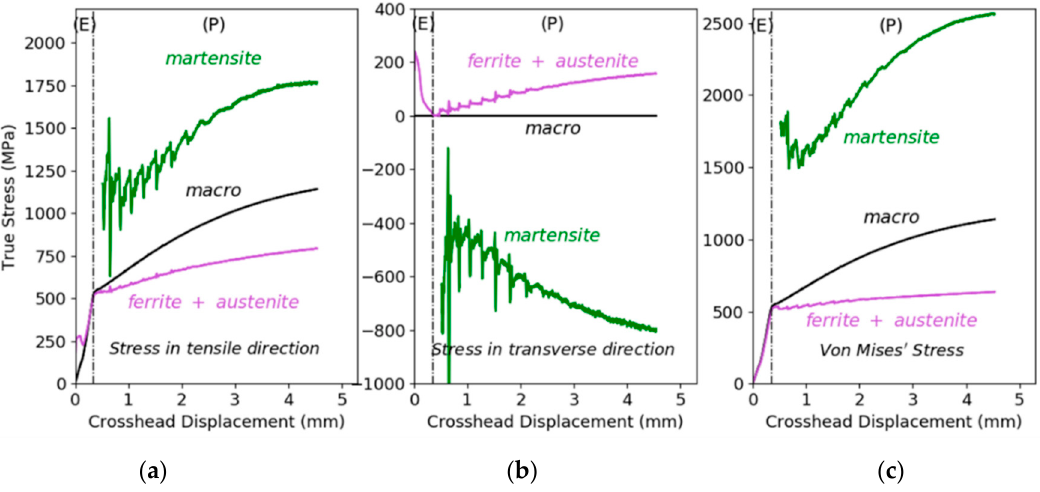
Figure 5. Comparison between macroscopic stress Σ i (black), ferrite, and austenite mixture law f α σ α i + f γ σ γ i (purple) and stress in martensite σ α ’i considering stresses in the tensile direction ( a ), stresses in the transverse direction ( b ), and von Mises stresses ( c